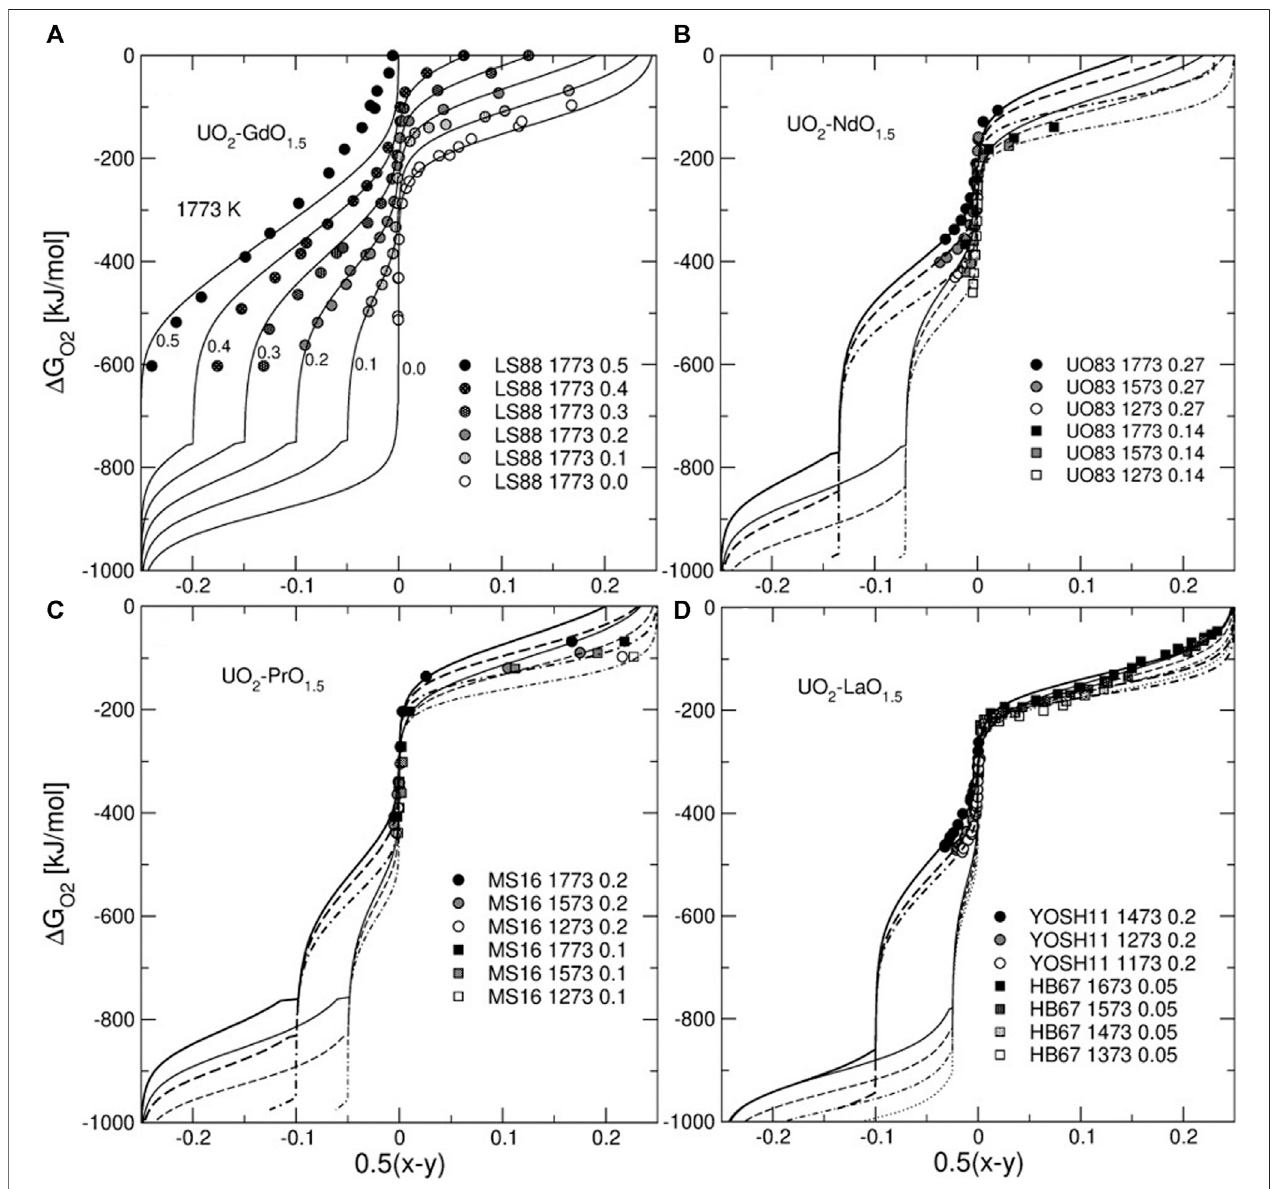
FIGURE 4 | Oxygen chemical potential plotted vs. non-stoichiometry parameter of U 1- z Ln z O 2+0.5( x-y ) . Lines are the isotherms predicted with the model. The temperature ranges in (b), (c), and (d) span the synthesis temperature interval given in the legend (the solid and the dotted lines correspond to the highest and lowest temperatures, respectively). The experimental data are from Lindemer and Sutton (Lindemer and Sutton, 1988), Une and Oguma (Une and Oguma, 1983a), McMurray and Silva (McMurray and Silva, 2016),Yoshida et al.(Yoshida et al., 2011) and Hagemarkand Broli (Hagemark and Broli,1967). Note an increase in the magnitude of the composition effect on the chemical potential of O 2 in the direction from La to